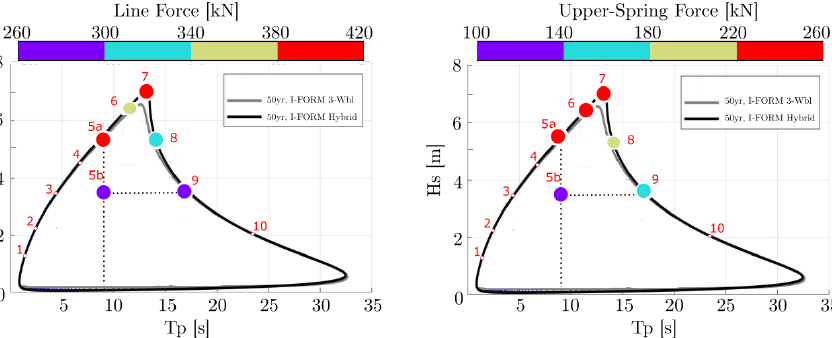
Figure 18. Colormap visualization of the maximum force in the connection line ( left ) and the maximum force ( right ) on the upper end-stop spring along the environmental contour line.